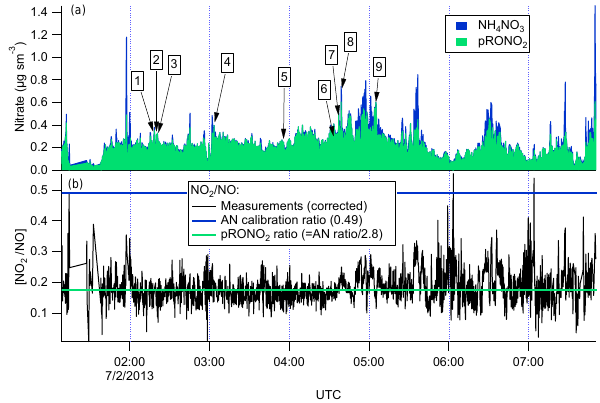
Figure 3. For the flight under consideration, the estimated relative contributions of ammonium and organic nitrate to the total corrected nitrate signal (a) was calculated from the ratios of the corrected peaks at m/z 30 and 46 (b) . Each of the plumes is identified here by / NO + (black data in b ) from the plume number. The ratios of NO + 2 corrected peaks at m/z 46 and 30, respectively, are compared to the ratios expected for ammonium nitrate (AN Calibration Ratio, blue horizontal line at 0.49) or organic nitrate (pRONO 2 Ratio, green horizontal line at 0.175), which is estimated from the AN calibration ratio using multiple data sets (see discussion in the Supplement). The measured ratio for most of the flight is more characteristic of organic nitrate than ammonium